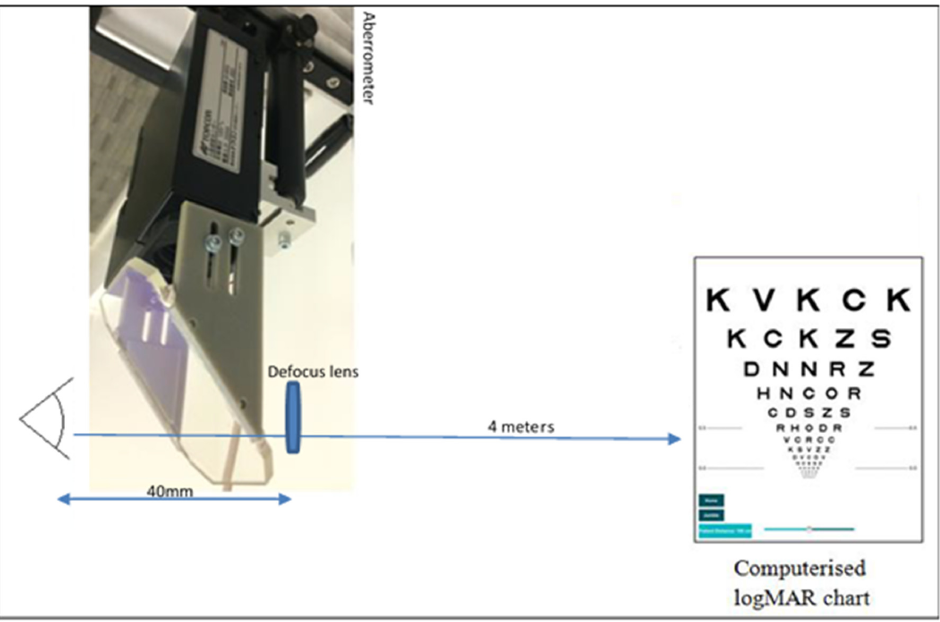
Figure 1. Schematic. Diagram illustrating the study